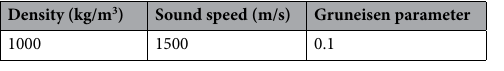
Table 5. Material properties of water 28